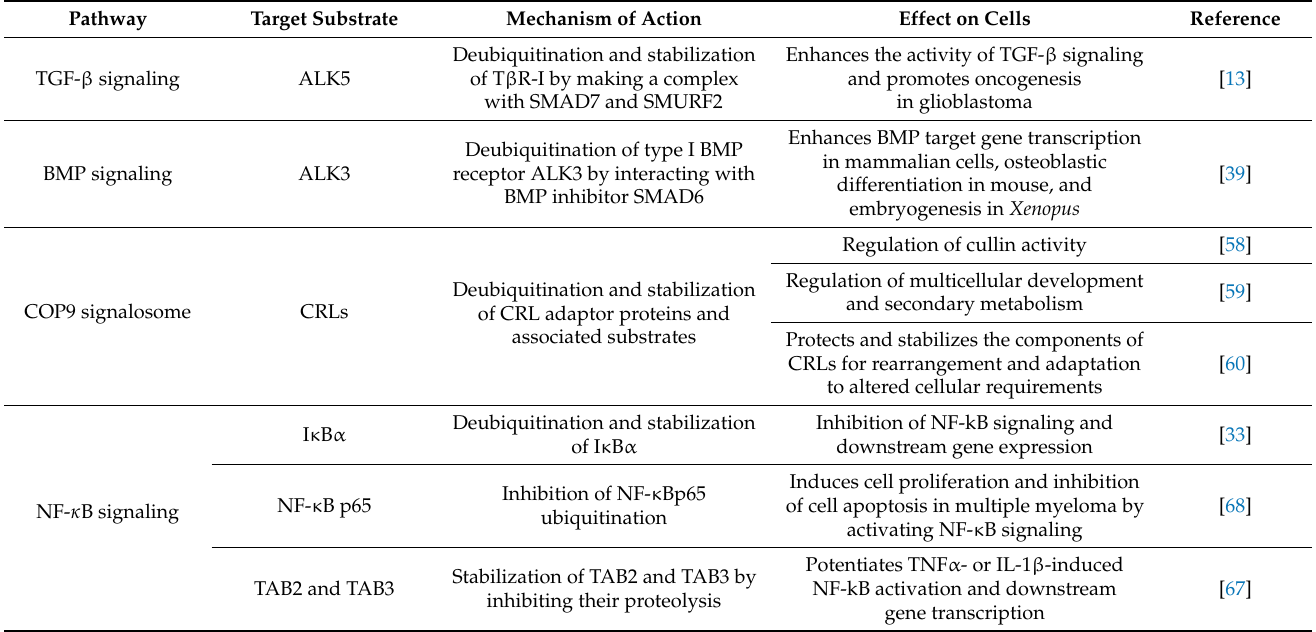
Table 1. USP15-regulated signaling pathways, target proteins, and their effects on cells.